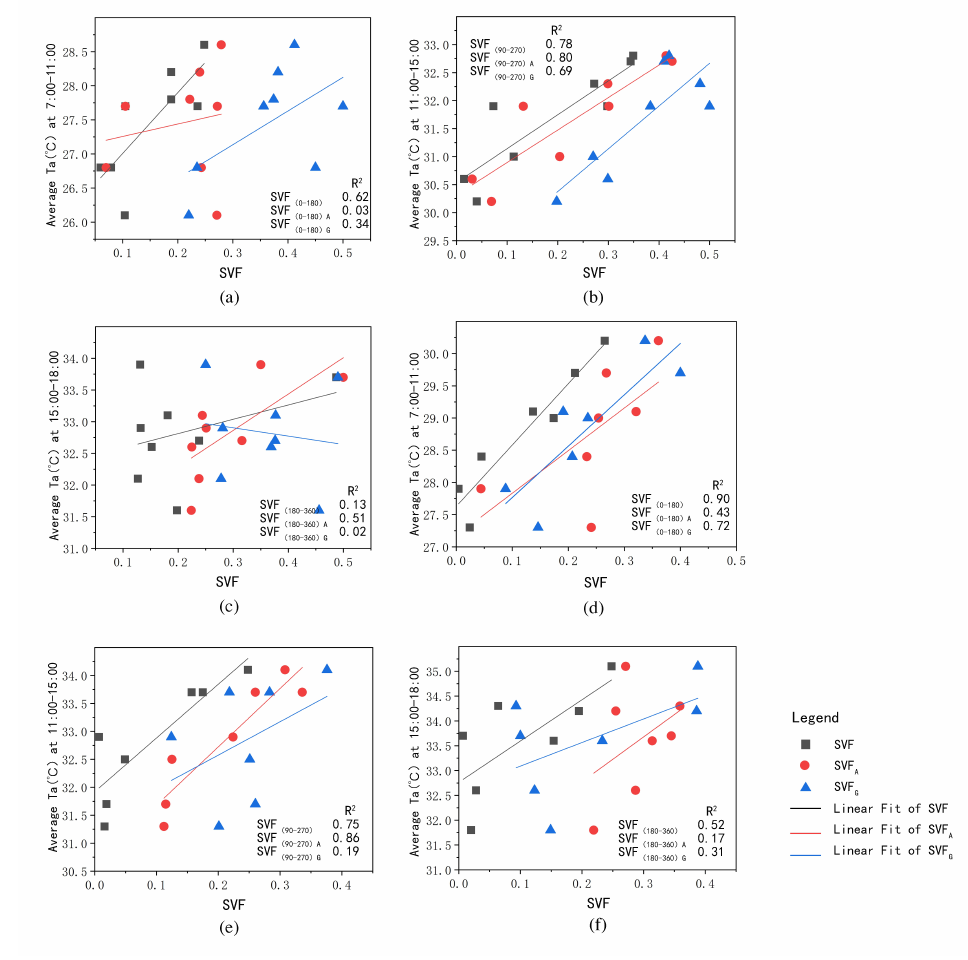
Figure 15. Average Ta and SVF, SVF A , SVF G of Shuangqing Estate ( a – c ), Xueqing Estate ( d – f